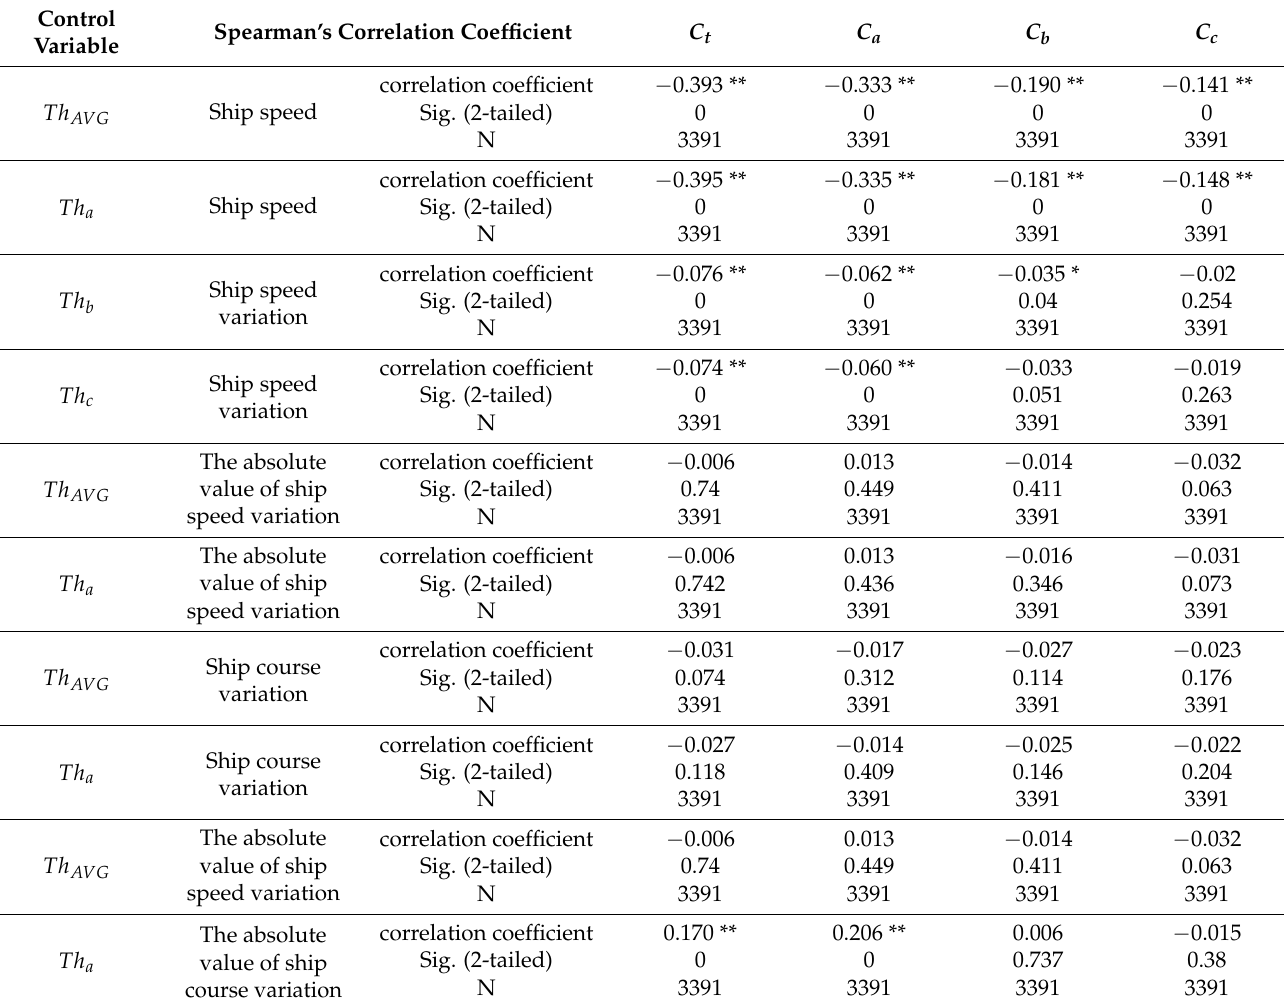
Table 7. Partial correlation analysis between sea ice conditions and ship movement characteristics with the control variable of ice thickness.